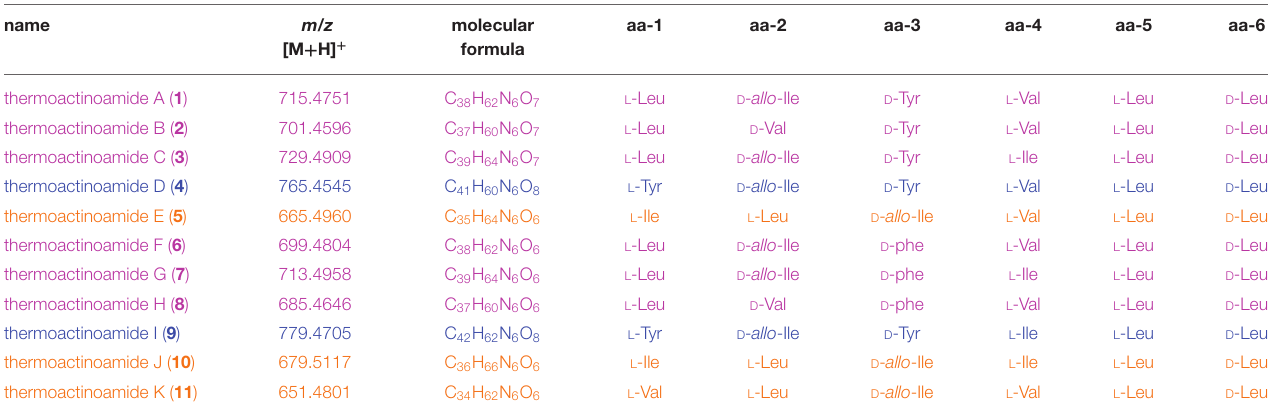
TABLE 3 | Thermoactinoamide variants from T. vulgaris DSM 43016.